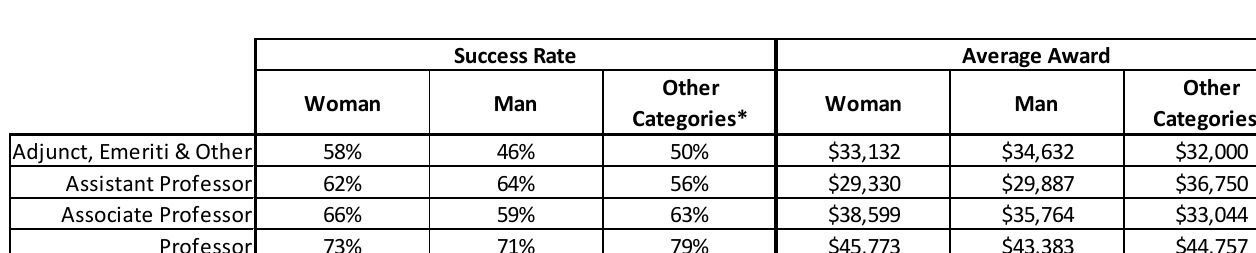
Discovery Grant Success Rate and Average Awarded Amount by Career Stage and Gender, 2020 Competition